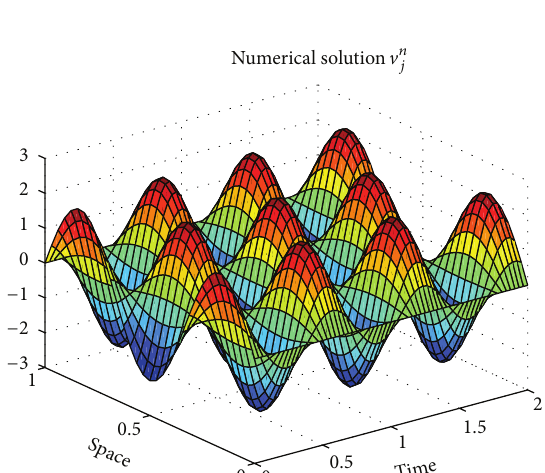
Figure 16: Partial